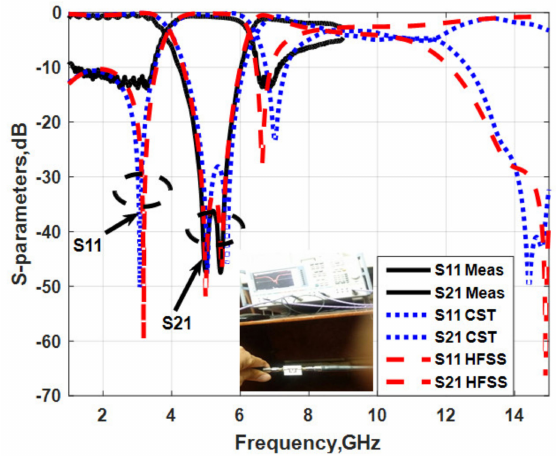
Figure 1. OLR with stub ( a ) 2-D configuration with dimensions ( b ) The fabricated photograph.